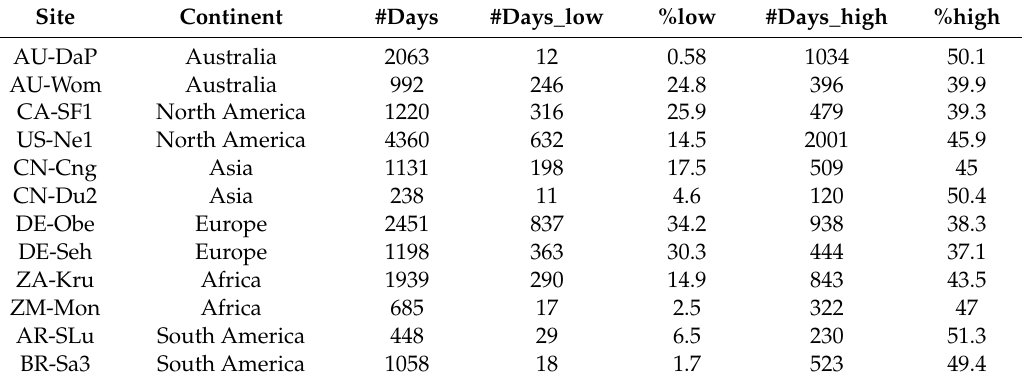
Table 4. Energy balance closure (EBC) statistics for each site. #Days column indicates the number of available daily measurements. #Days_low gives the number of days with < 70% EBC along with its percentage (%low). #Days_high gives the number of days with > 100% EBC along with the corresponding percentage of days